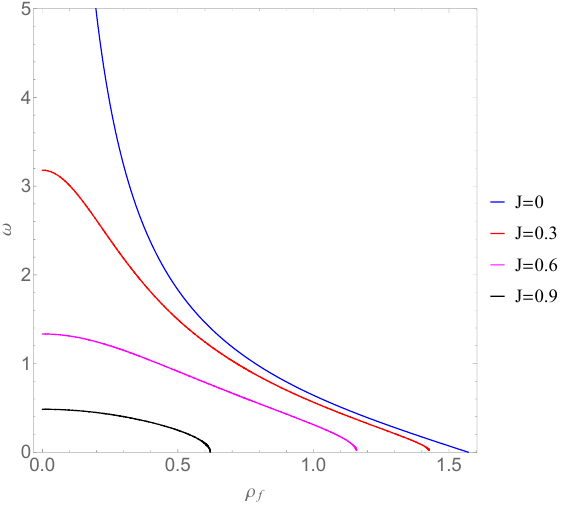
Figure 5 . The angular velocity ω as a function of ρ f ( J is in the unit of N f R 2 /α 0